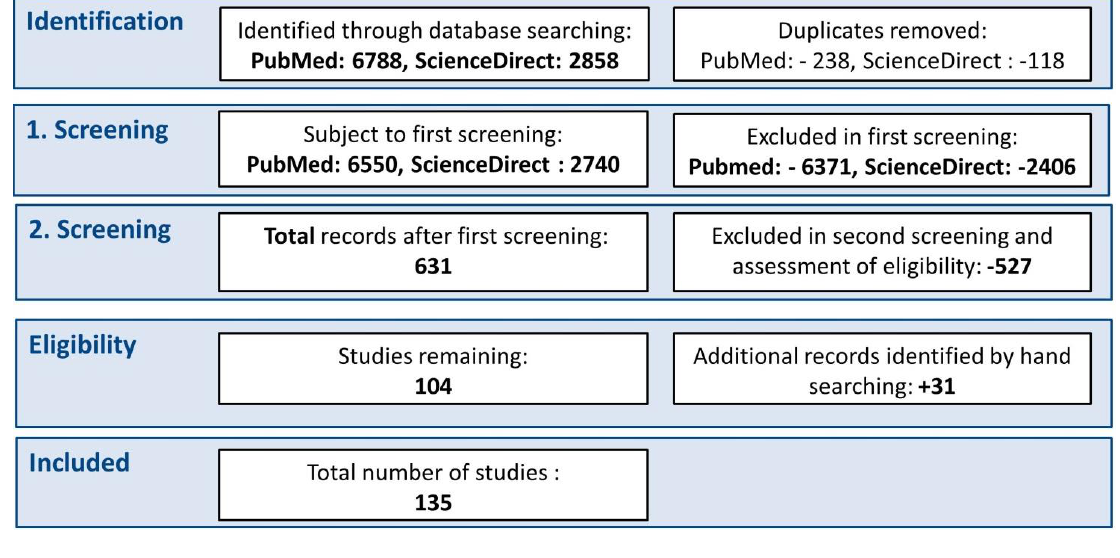
Figure 1. Flow chart. Table 1. Screened results of literature